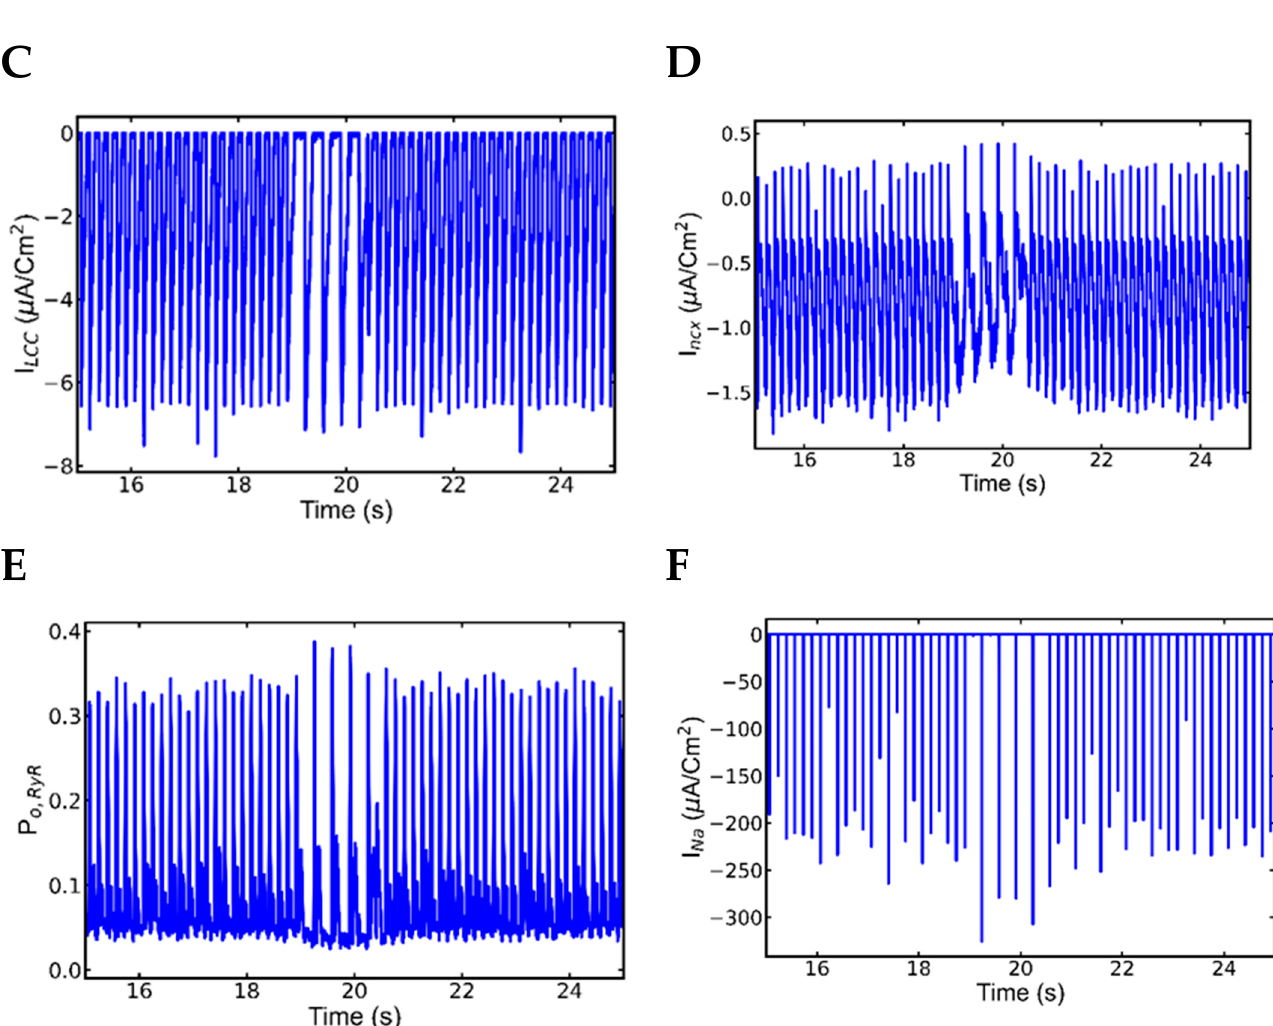
Figure 9. The Ca 2+ transients, channel openings and ionic currents also reflect the patterns of alternans and the beat skipping in them. ( A ) Myoplasmic Ca 2+ concentration ([Ca 2+ ] myo ), ( B ) NSR Ca 2+ concentration ([Ca 2+ ] nsr ), ( C ) L-type Ca 2+ channels, ( D ) Na + -Ca 2+ exchange current (I ncx ), ( E ) RyR2 openings, ( F ) Na + current (I Na ). The simulation was repeated 10 times with different seeds for the pseudo random number generator and the patterns observed were repeated each time. Shown here is a representative simulation.